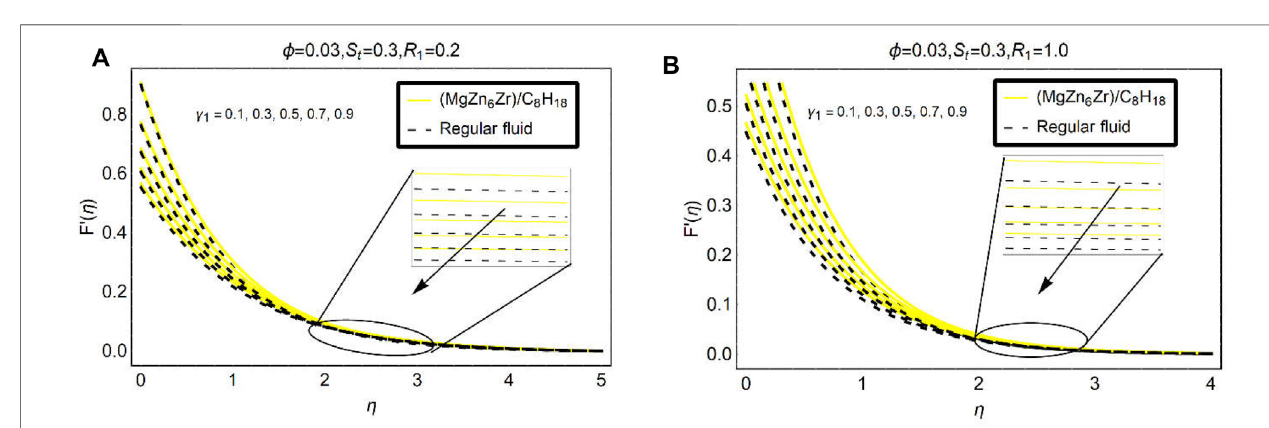
FIGURE 4 | Velocity via γ 1 (the slip parameter) for (A) R 1 (cid:2) 0 . 2 and (B) R 1 (cid:2) 2 . 0.